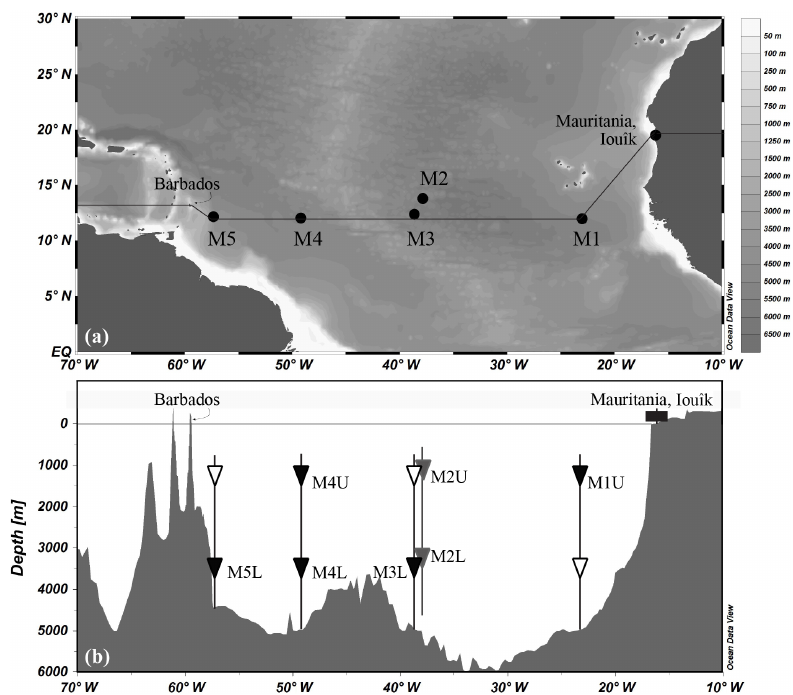
Figure 1. (a) Location of land-based dust collectors on the Mauritanian coast in the village of Iouîk and sediment trap moorings M1– M5 between north-west Africa and Barbados. (b) Bathymetric profile, on the line in (a) , through the equatorial North Atlantic between Mauritania (15 ◦ W) and Barbados (60 ◦ W), showing the five moorings with sediment traps (triangles) and the land-based MWAC dust collectors (rectangle). M x U and M x L indicate the upper and the lower traps on the five moorings at 1200m and 3500m nominal water depth, respectively. Open symbols refer to sediment traps that failed or were lost during